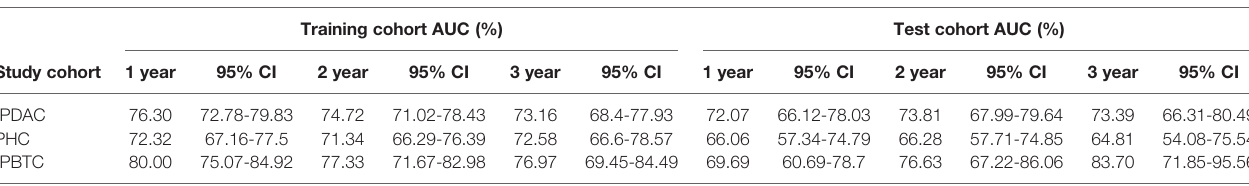
TABLE 6 | Time-dependent ROC curve